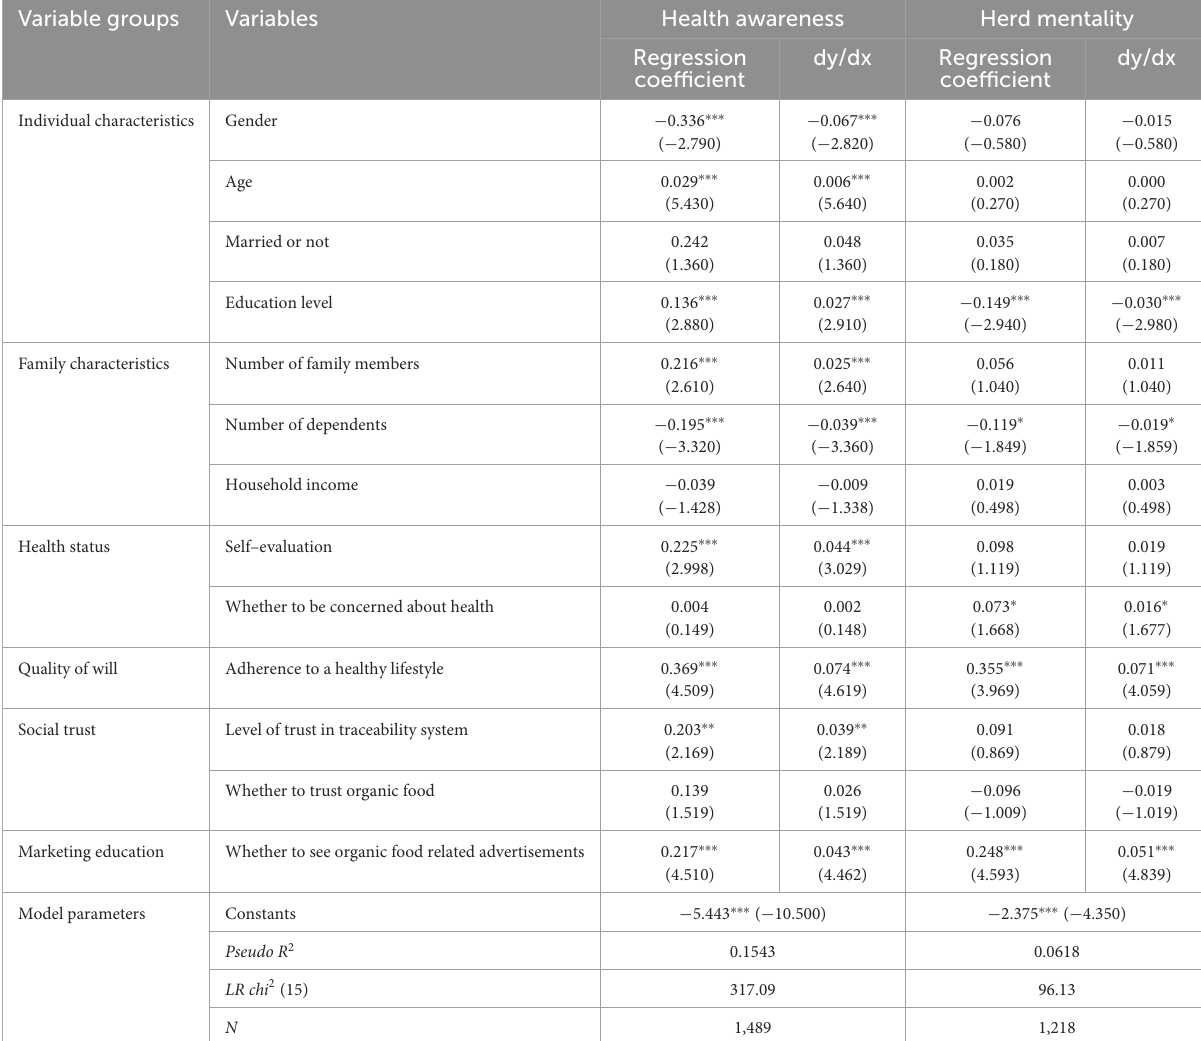
TABLE 3 Logit regression results for consumer beliefs.